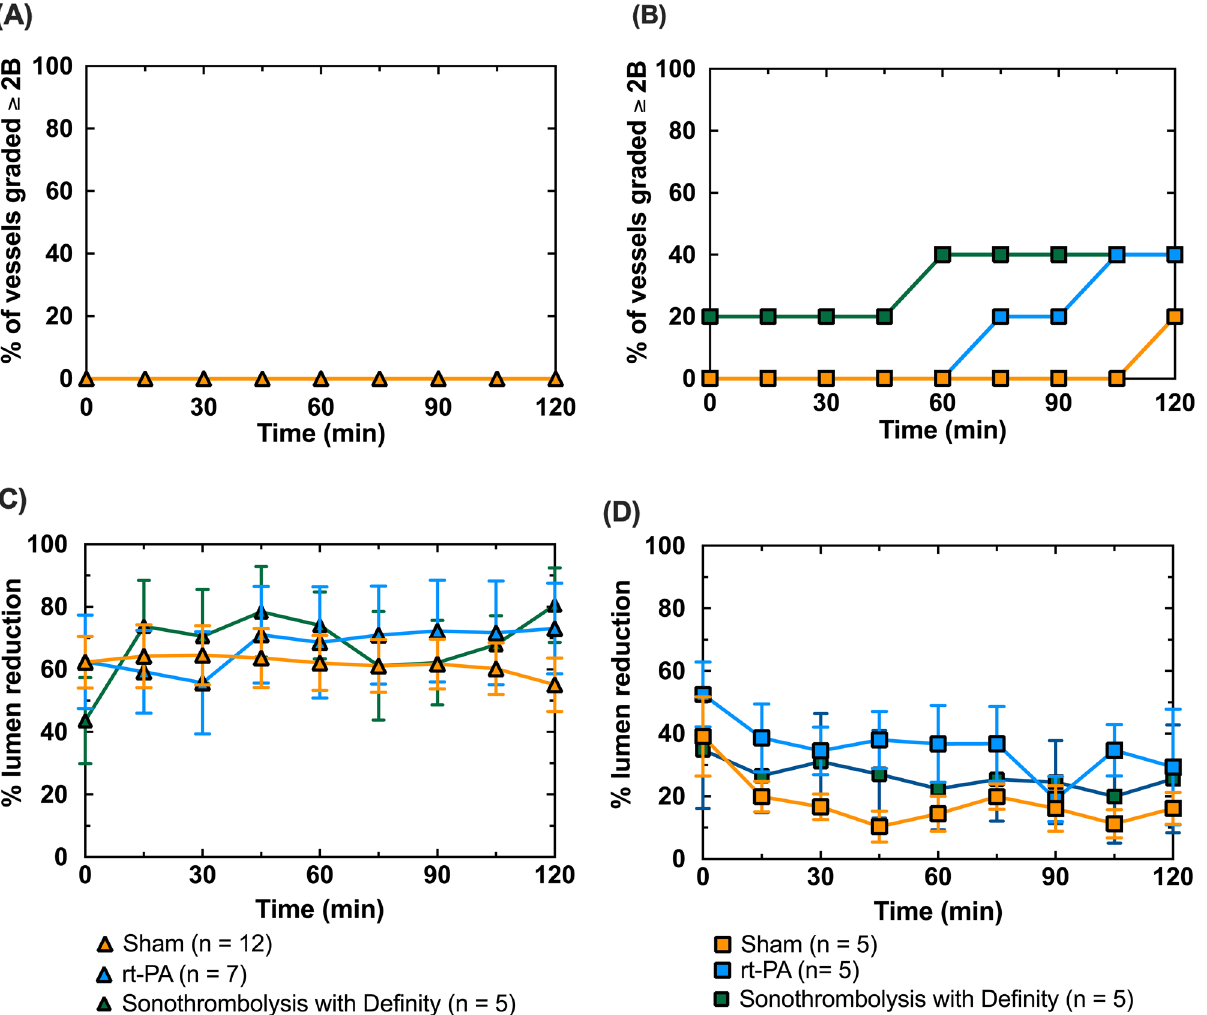
Figure 3. Reperfusion mTICI scores for ( A ) clots treated using the end-hole microcatheter or ( B ) the multiple- side-hole microcatheter. For plot ( A ), n = 12 for sham, n = 7 for rt-PA only, and n = 5 for sonothrombolysis with Definity. In plot ( B ), n = 5 for all three treatment arms. No recanalization up to or greater than mTICI = 2b was observed for any clots treated with the end-hole microcatheter ( A ). Reperfusion was accelerated for the rt-PA only treatment arm (75–105 min), and even more for sonothrombolysis with Definity (0–60 min) compared to sham ( B ). Percent APA lumen reduction, was used to quantify vasospasm based on DSA for the end-hole ( C ) and multiple side hole ( D )